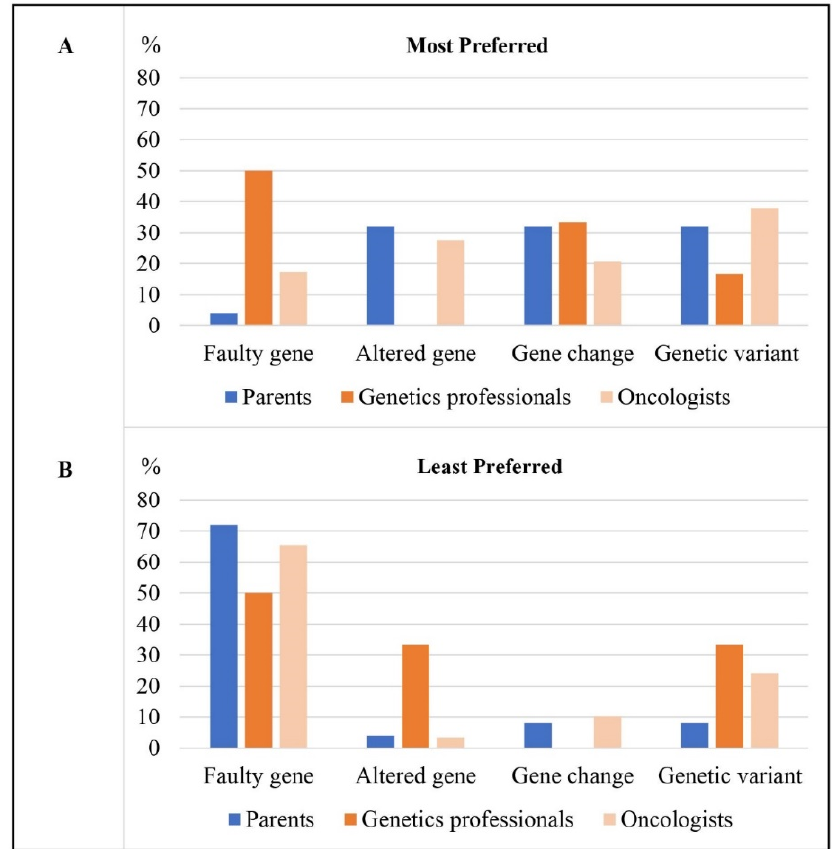
Figure 2. Percentage of participants in each participant group (n = 25 parents, n = 6 genetics professionals, n = 29 oncologists) who ( A ) most preferred each term and ( B ) least preferred each term.